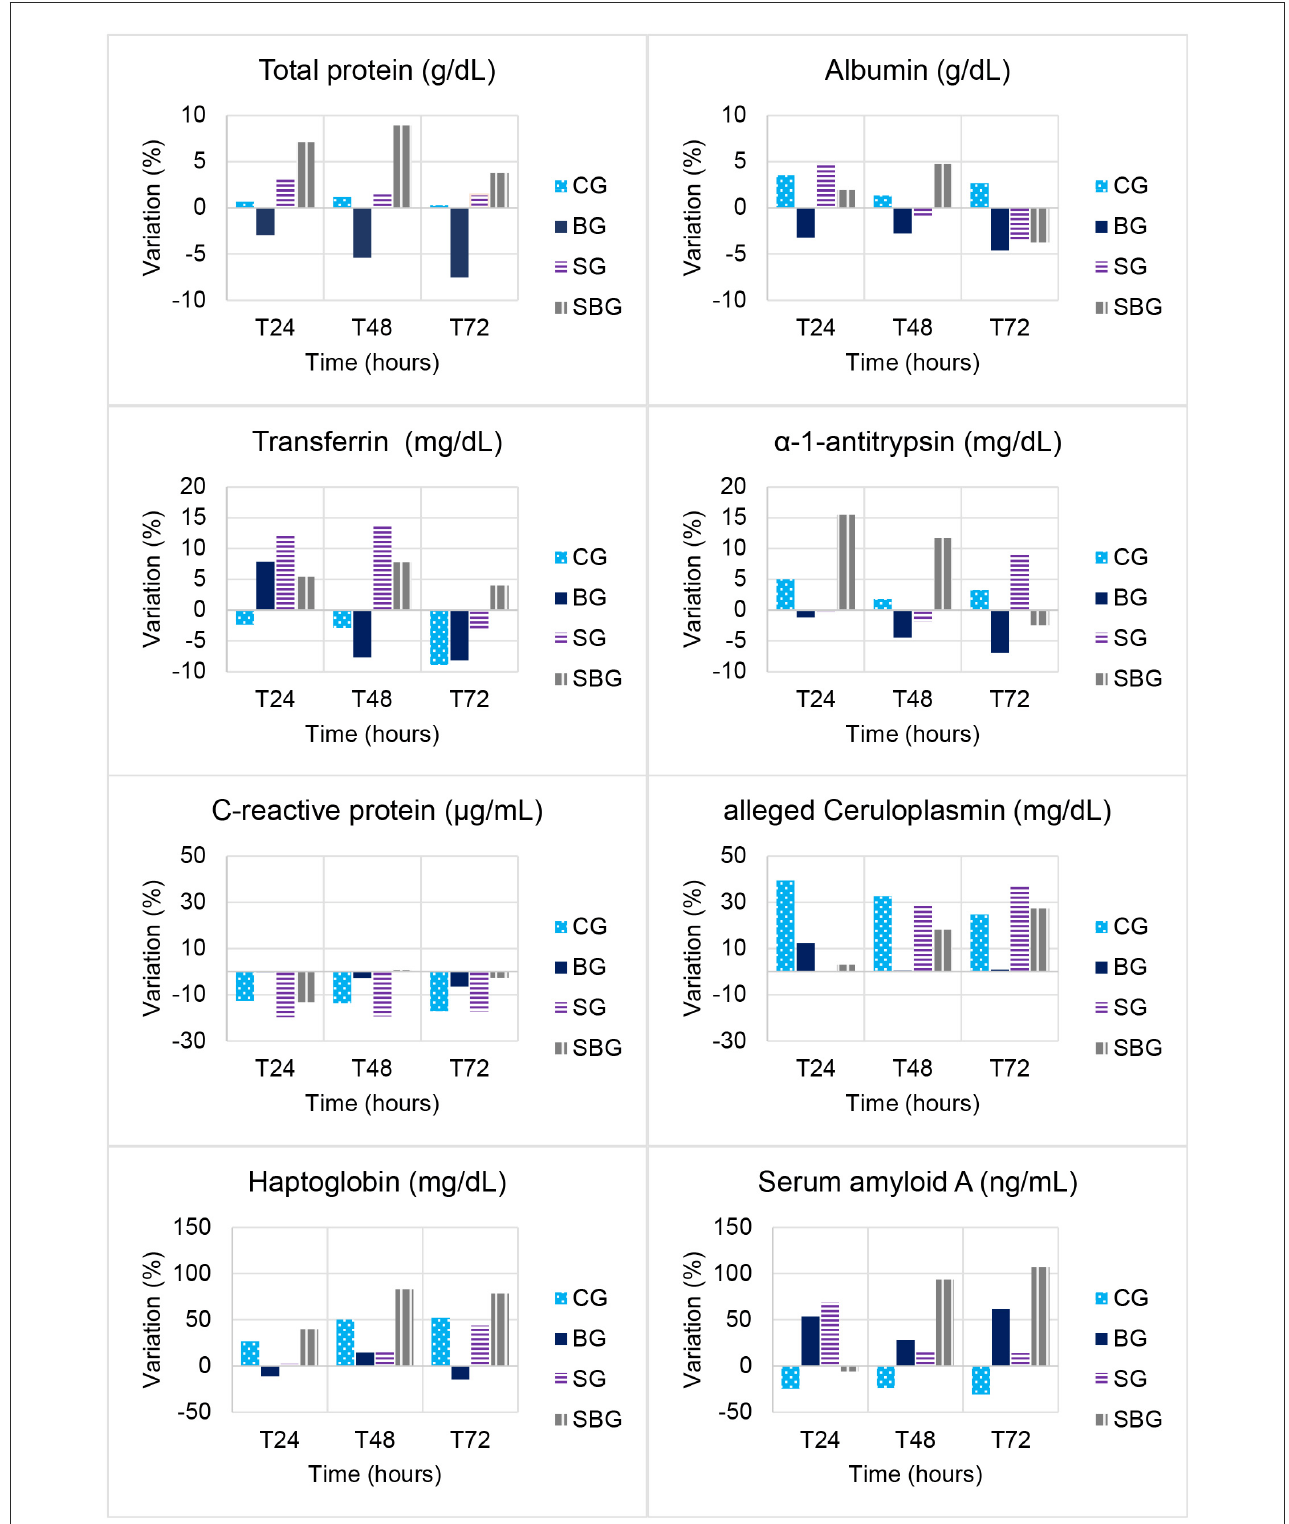
FIGURE2 Variation (%) from baseline over time (T0h, T4h, T8h, T12h, T24h, T48h, and T72h) in total serum protein, albumin, transferrin, α -1-antitrypsin, C-reactive protein, alleged ceruloplasmin, haptoglobin and serum amyloid A concentrations in horses submitted to experimental laminitis (CG, control; BG, buffer; SG, starch; SBG,